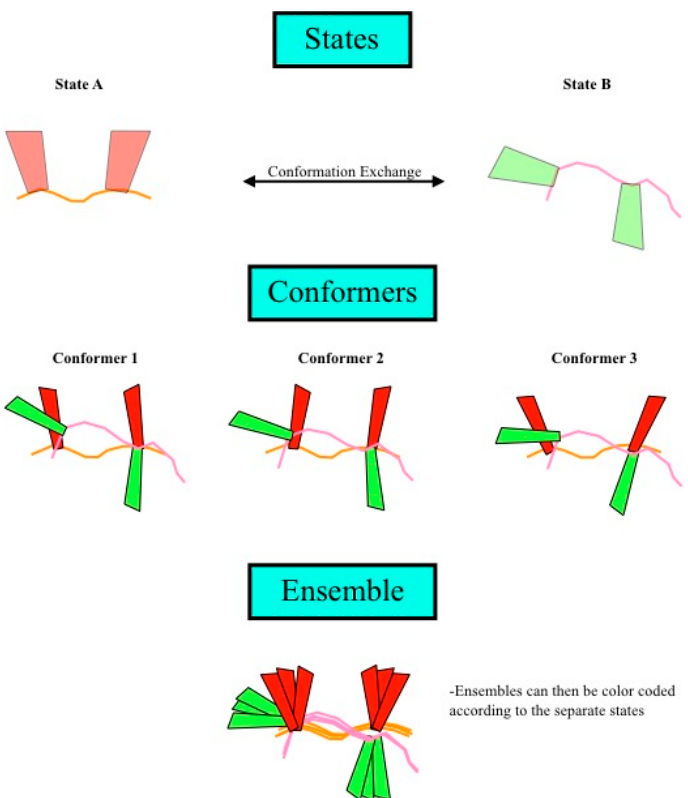
Figure 4. Definition of states, conformers, and ensembles. ( Top ) Shown are two different states of a theoretical protein, with each individual state being defined as one set of coordinates for all the atoms of a molecule. Structure calculation using this data would result in a single conformer that satisfied the data well and could be composed of one or more states; ( Middle ) The structure calculation is repeated multiple times, resulting in many conformers; ( Bottom ) Finally, the ensemble is the superposition of all of the conformers. If multiple states were allowed in the structure calculation, then the ensemble could be divided into sub-bundles, each of which would be identified by structural similarity in the region of interest, which corresponds to a single state.